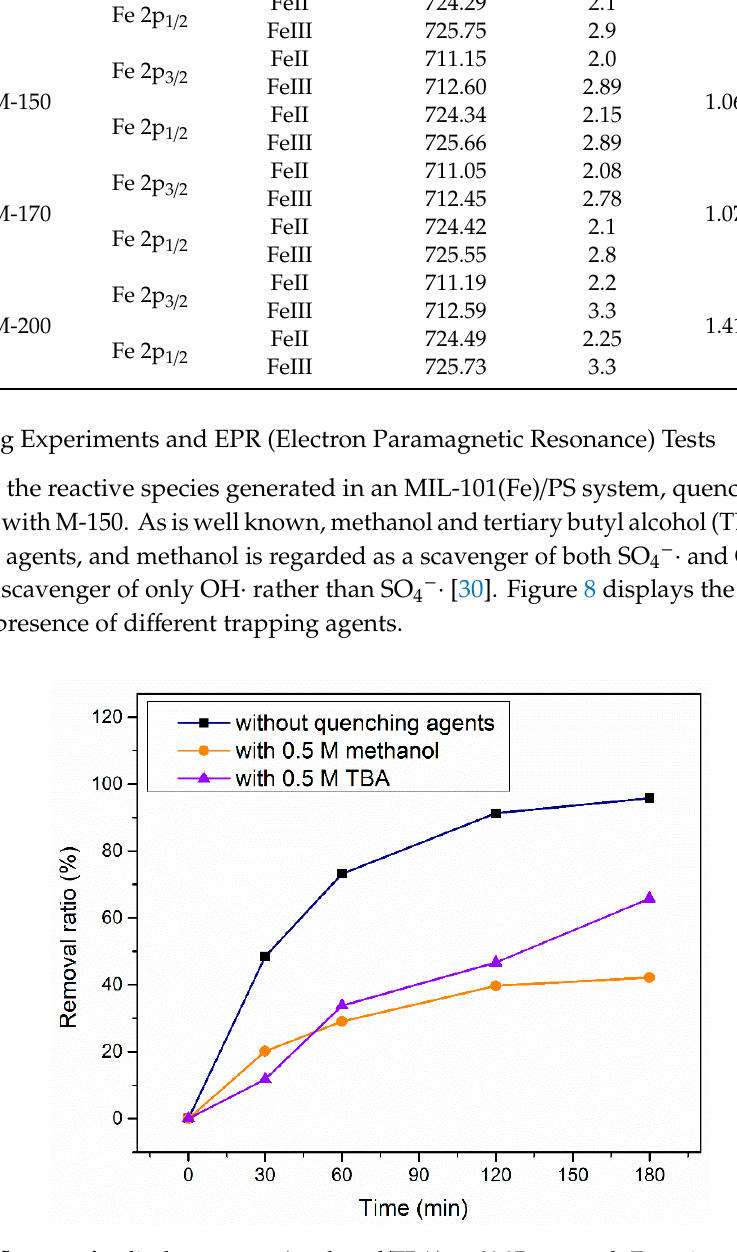
Figure 8. Influence of radical scavenger (methanol / TBA) on X-3B removal. Experimental conditions: